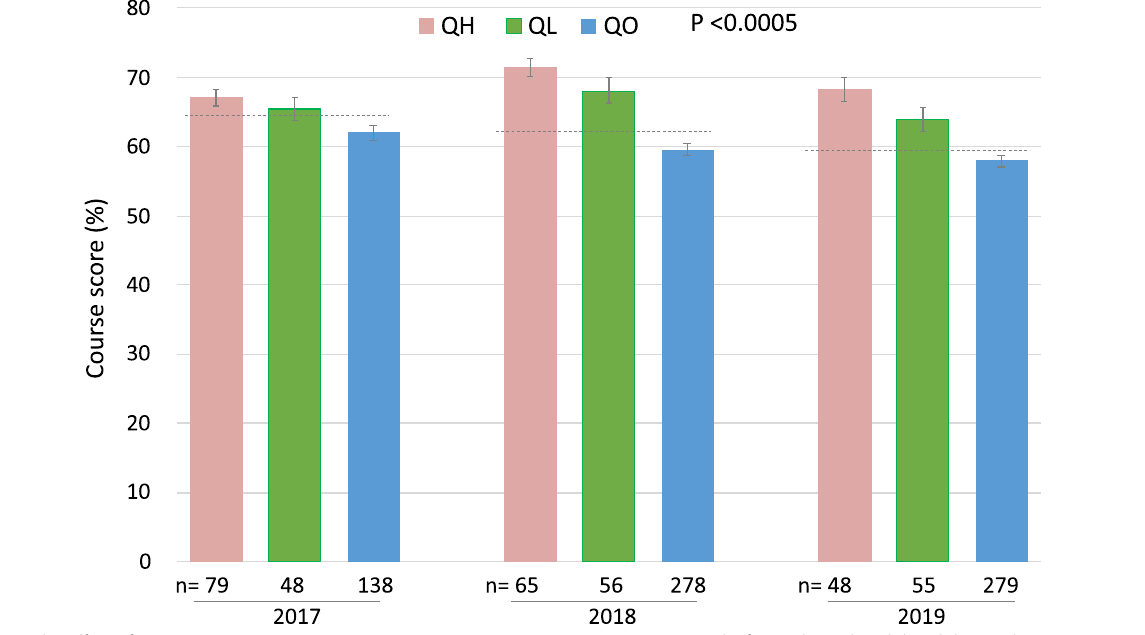
Fig. 3 The effect of quecture engagement on course scores over 3 years. Average course results for students that did or did not submit quecture questions are shown for each of three consecutive yearly course iterations. For each year the class course average is indicated by a broken line (64.2% in 2017, 62.4% in 2018 and 59.5% in 2019). Standard error of the mean is shown for each sub-group. QH high quecture engagers, QL low quecture engagers, Q0 students that did not engage with quectures. Both high and low quecture engagers have significantly higher scores than those who did not submit a quecture question (Tukey P < 0.05 for QH vs Q0 and QL vs